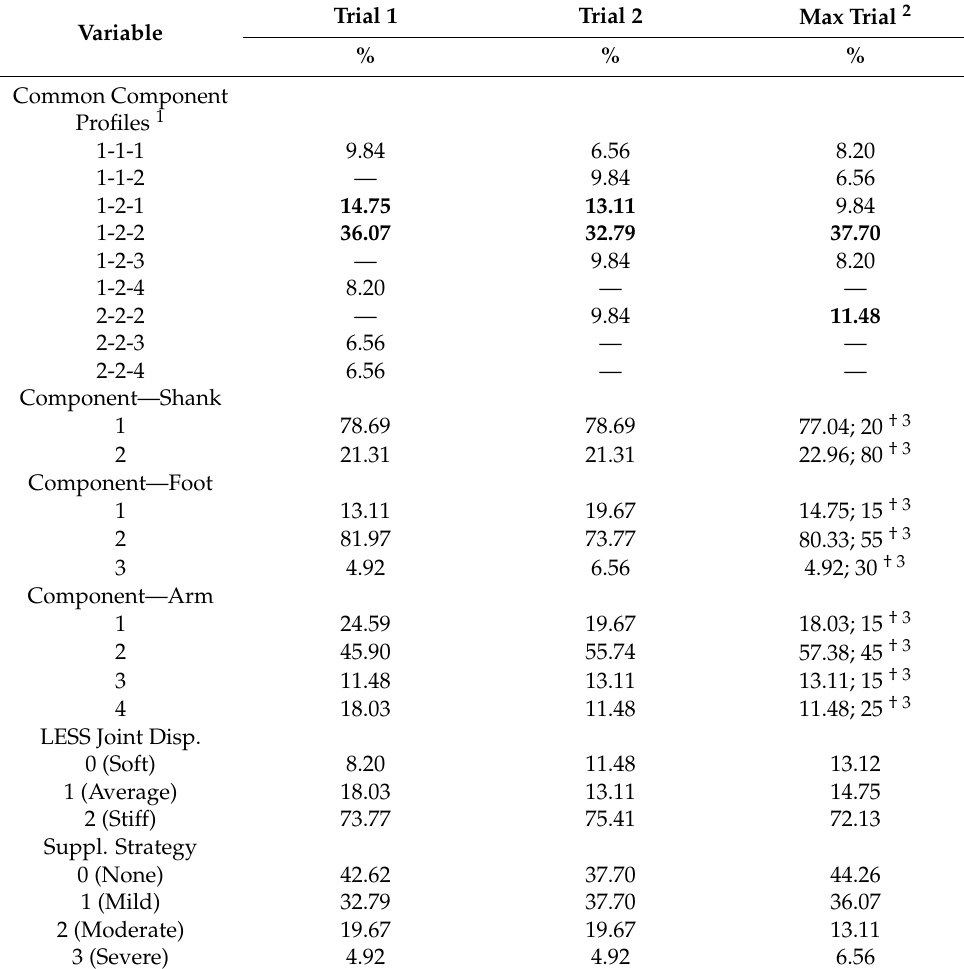
Table 2. Percentages of occurrence for individual SLJ trials and the isolated (max) trial, which was composed of scores from the trial with the longest SLJ distance. Trial 1 Variable Common Component